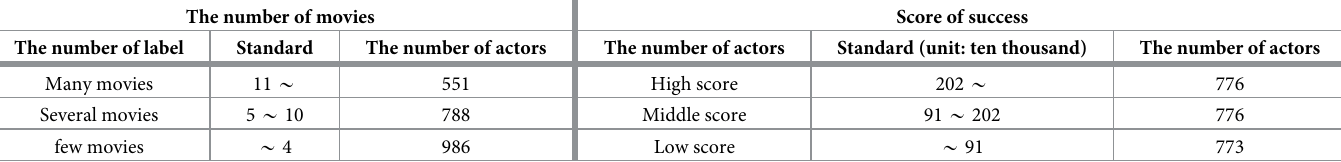
Table 2. Actor’s characteristic labeling.